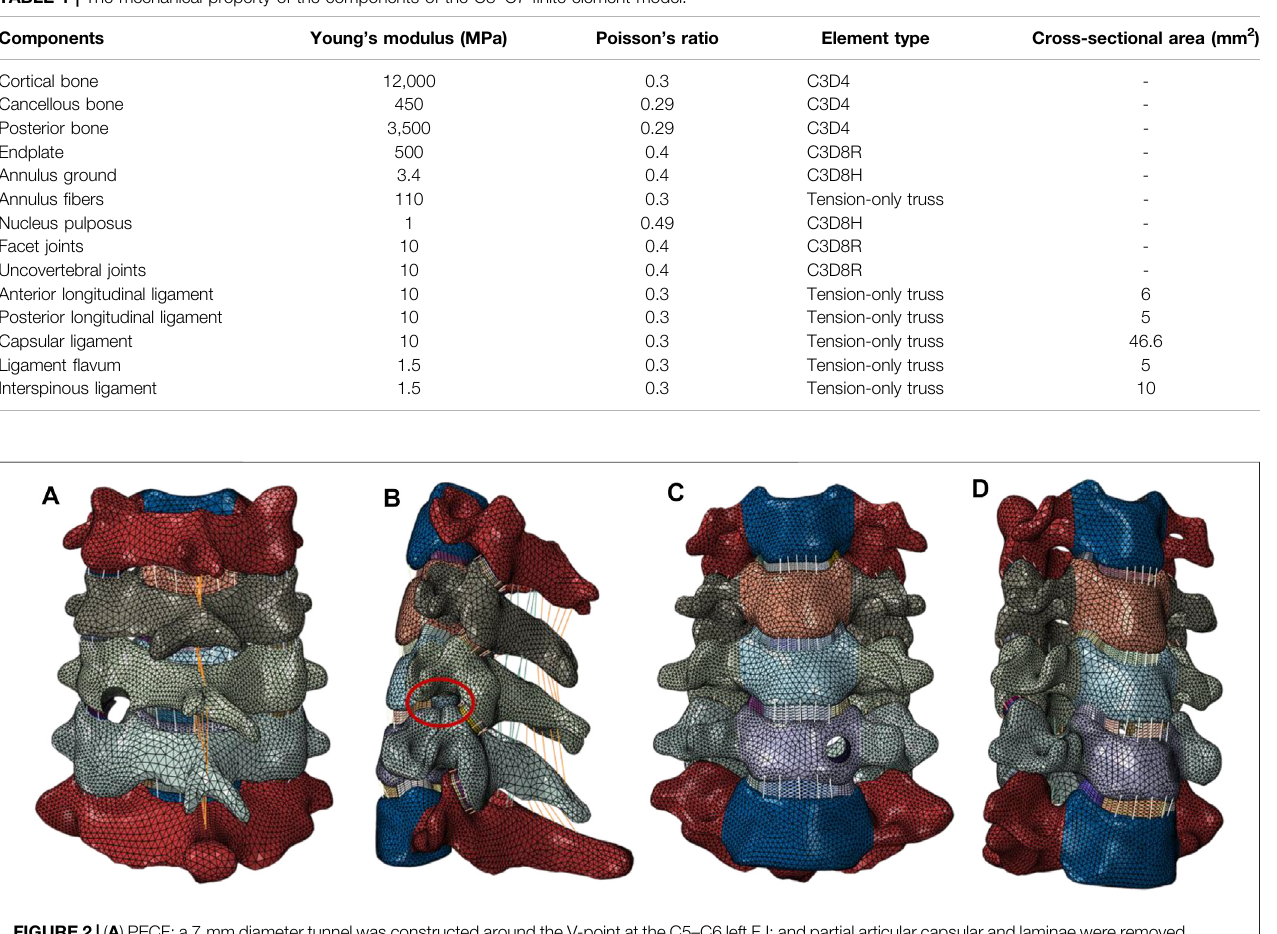
FIGURE 2 | ( A ) PECF: a 7 mm diameter tunnel was constructed around the V-point at the C5 – C6 left FJ; and partial articular capsular and laminae were removed. ( B ) MACF: the posterior part of the left UJ was removed at the C5 – C6 segment without disc resection. ( C ) ATc-ECD: a 6 mm diameter tunnel was designed on the C6 vertebralbodyleftsidefromanteriorinferiortowardsposteriorsuperior,andendoscopicinstrumentscanreachtheregionofthecompressednerveroot.( D )ATd-ECD:a 3.9 mm diameter tunnel was constructed at the C5 – C6 intervertebral space from the right front to the left rear, and the target area was the left lateral